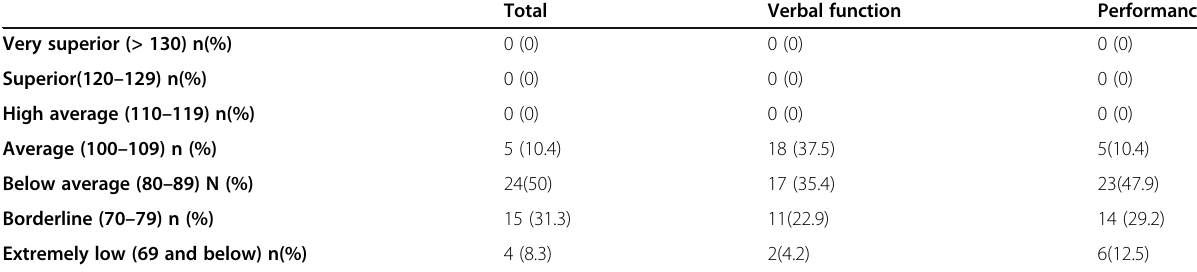
Table 2 Wechsler Adult Intelligence Scale among Parkinson disease patients (WAIS) Total Verbal function Performance